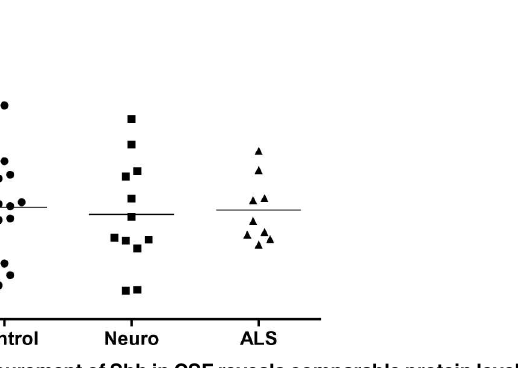
the disease course. The mean ALSFRS-R score was 44.9 ± 1.8 (out of 48), again reflecting early disease presentation. The CSF total protein levels were not significantly different among the groups, and the cell counts in all samples fell within normal limits.